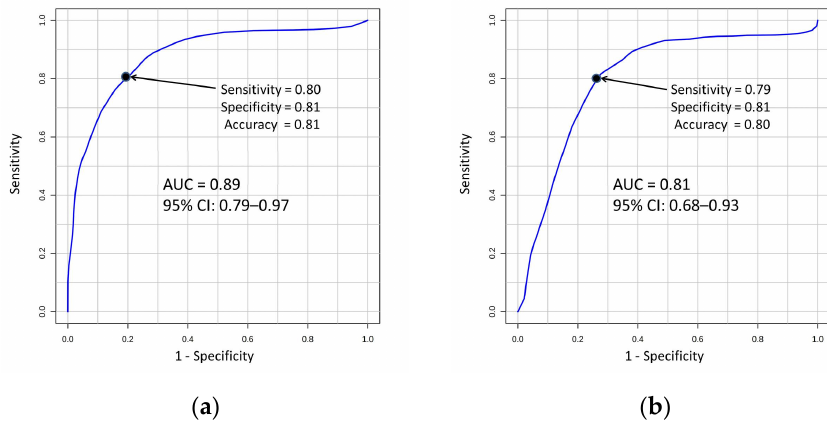
tions for the diagnosing of DN cases in patients with T1D (Table 3). For the diagnosing of